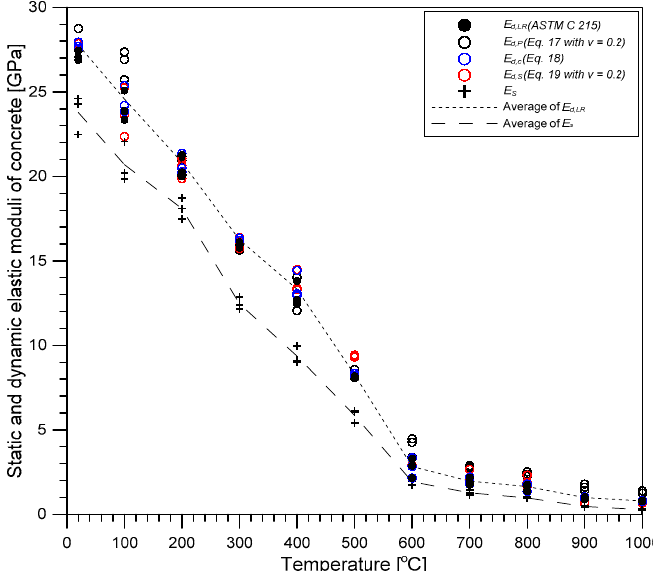
Figure 10. The variation of dynamic- and static elastic moduli of concrete with temperature. The dynamic elastic moduli of E d,P and E d,S was based on the constant Poisson’s ratio of 0.2. For comparison, three dynamic elastic moduli were evaluated from the three elastic wave Table 1. RMSE values between the three velocity dynamic elastic moduli ( E d,C , E d,P or E d,S ) and the standard dynamic elastic modulus ( E d,LR ) with different Poisson’s ratios.